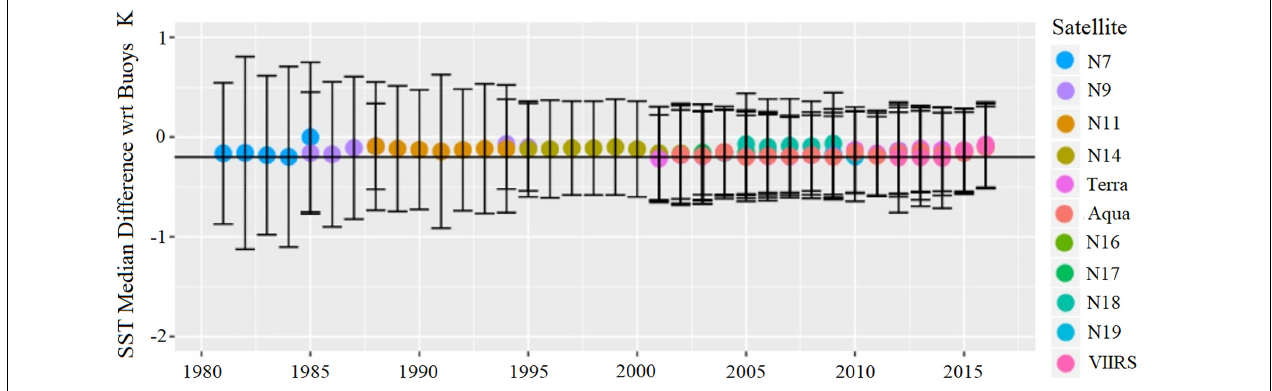
FIGURE 10 | Annual median and interquartile range of satellite SST skin versus SST depth from drifting buoys for a combined timeseries of AVHRR Pathfinder SSTs from NOAA-7 to -19, MODIS on Terra and Aqua, and S-NPP